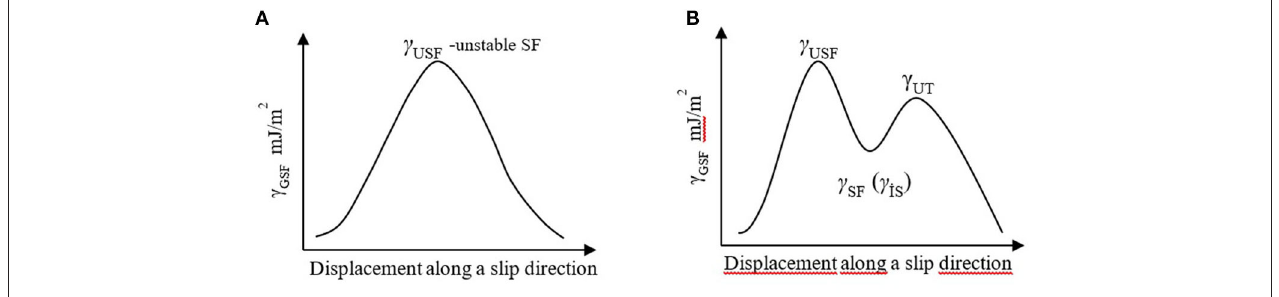
FIGURE 2 | Typical computed GSFE curves. (A) the maximum ( γ USF , unstable SF) represents the energy barrier for dislocation dissociation and implies that formation of SF is not possible; (B) if two maxima exist, the first one still shows the energy barrier for the formation of a stacking fault, which means dissociation of dislocation is possible, and the trough ( γ SF , also termed as γ IS , -intrinsic SF-) shows the energy of a stable SF. The second maximum in this case corresponds to the energy barrier for the formation of a